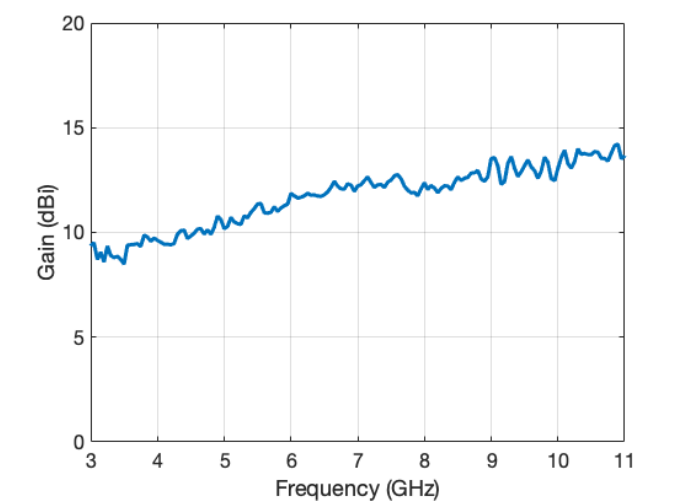
Figure 4. Antenna gain as a function of frequency in the main direction of